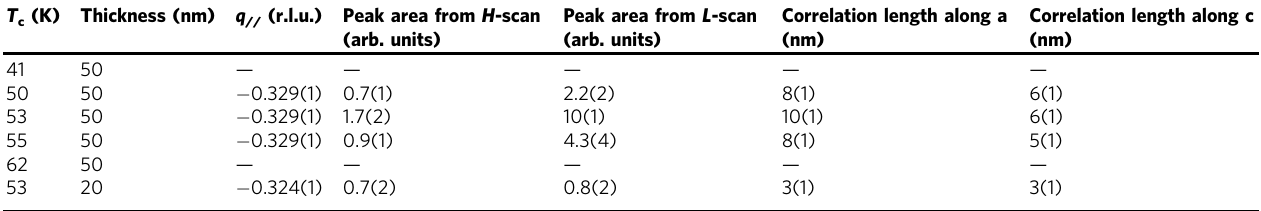
Table 1 Fitting of the 3D-CO